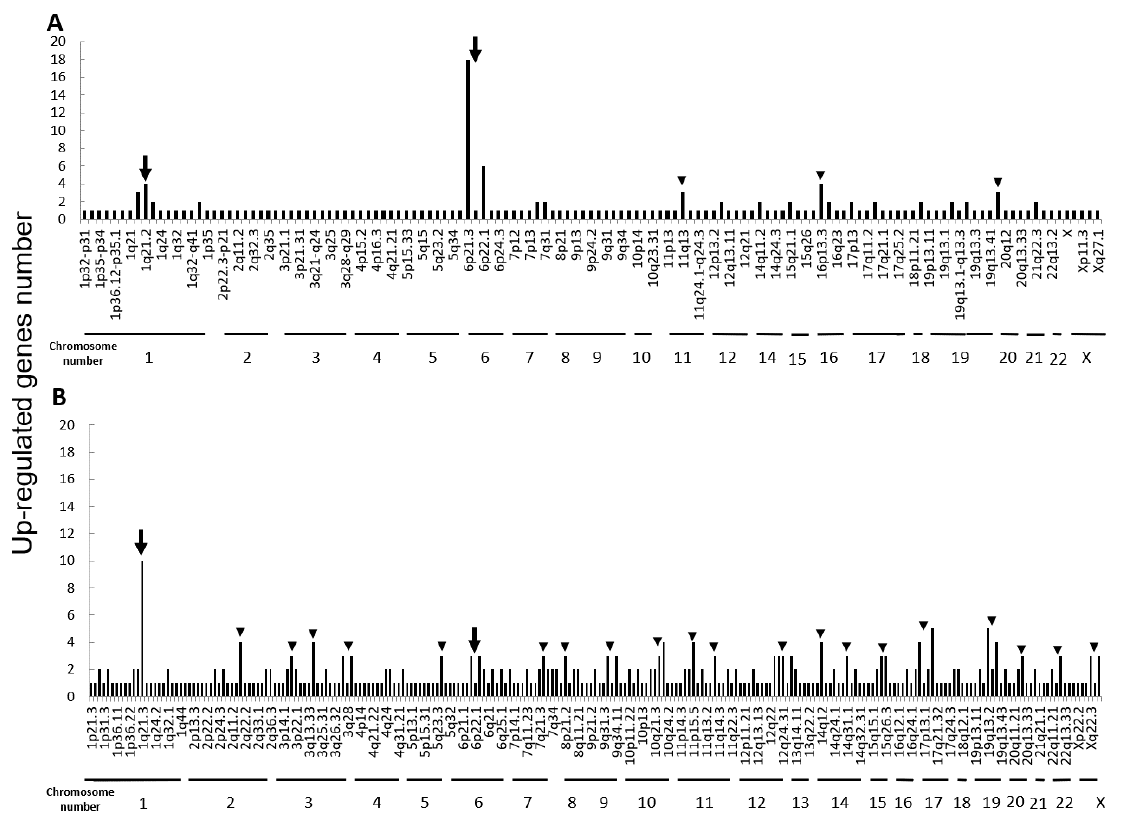
Figure 2. Chromosomal location of up-regulated genes in IR cells from microarray data. Up-regulated gene numbers are displayed on the vertical axis and genome locations from chromosome 1 to chromosome X are plotted along the horizontal axis. ( A ) The human non-small cell lung cancer cell line H1299. ( B ) The human breast cancer cell line MCF7. The arrowheads represent chromosomal locations where three or more differentially expressed genes are present, and the arrow represents the loci that are common to both H1299-IR and MCF7-IR cells.